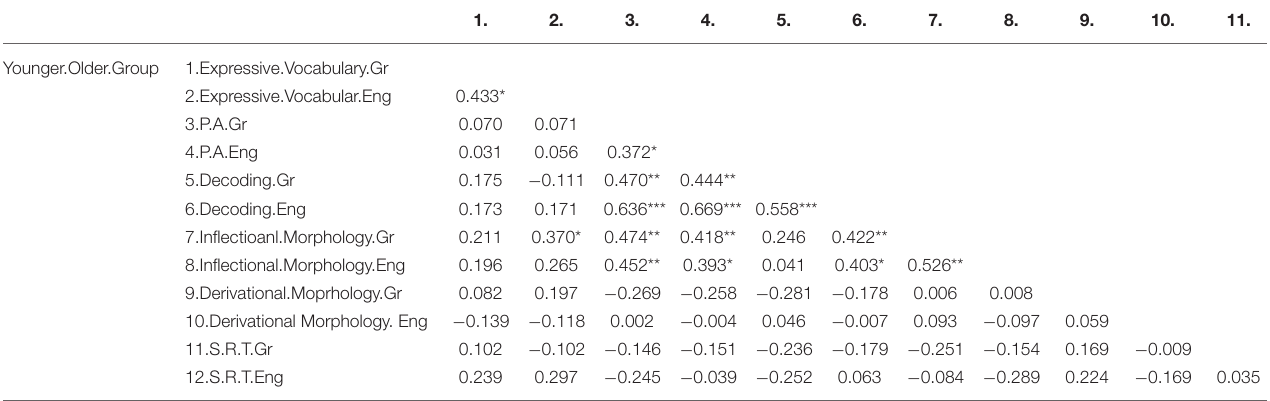
TABLE 7 | Partial-correlation matrix for children’s performance on expressive vocabulary, phonological awareness, morphological awareness, morpho-syntactic skills, decoding in Greek and English controlling for age.